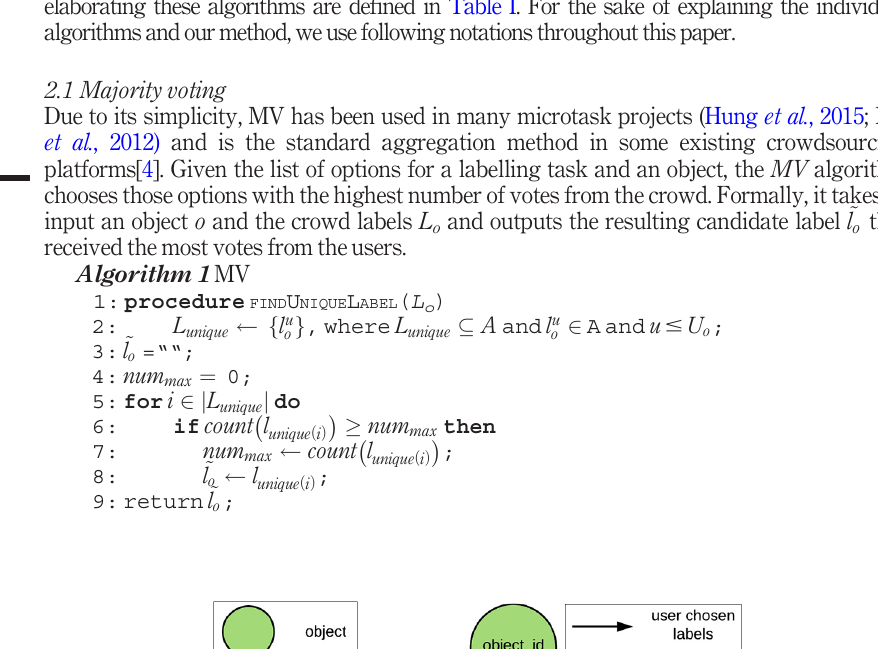
Figure 3. Representation of a task with a single question